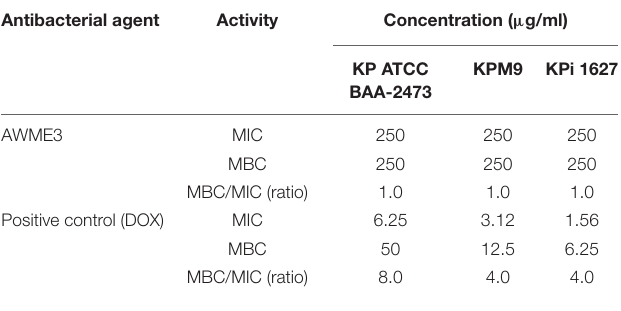
TABLE 3 | Antibacterial activity measured by the MIC and MBC of AWME3 against K. pneumoniae strains. Antibacterial